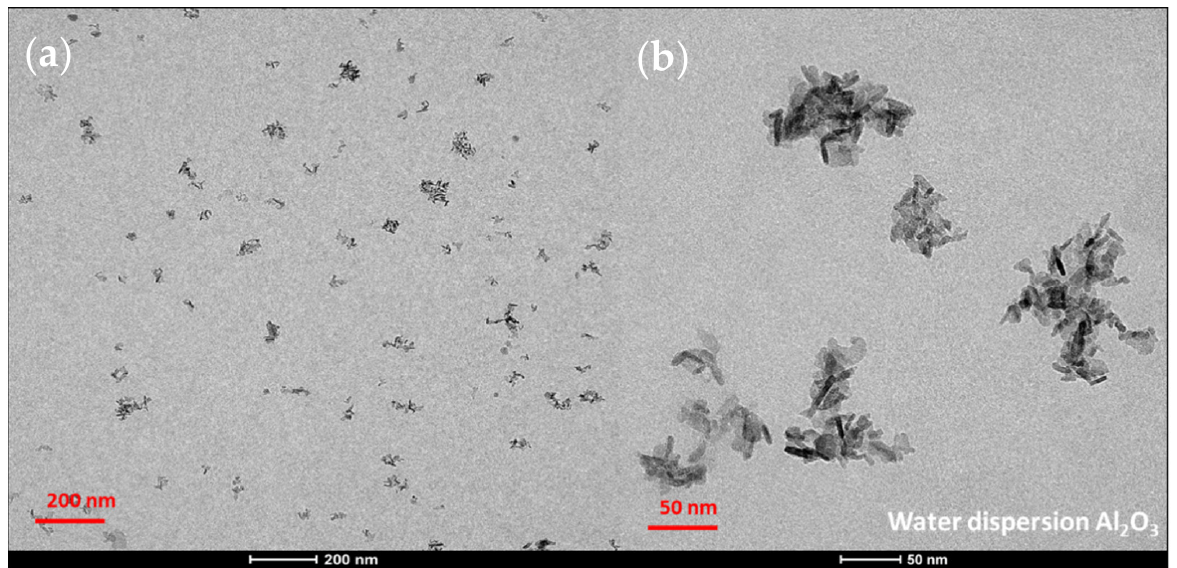
Figure 11. TEM micrographs for the 3 wt.% nanocomposites obtained ( a ) by solvent casting and ( b ) by melt blending.